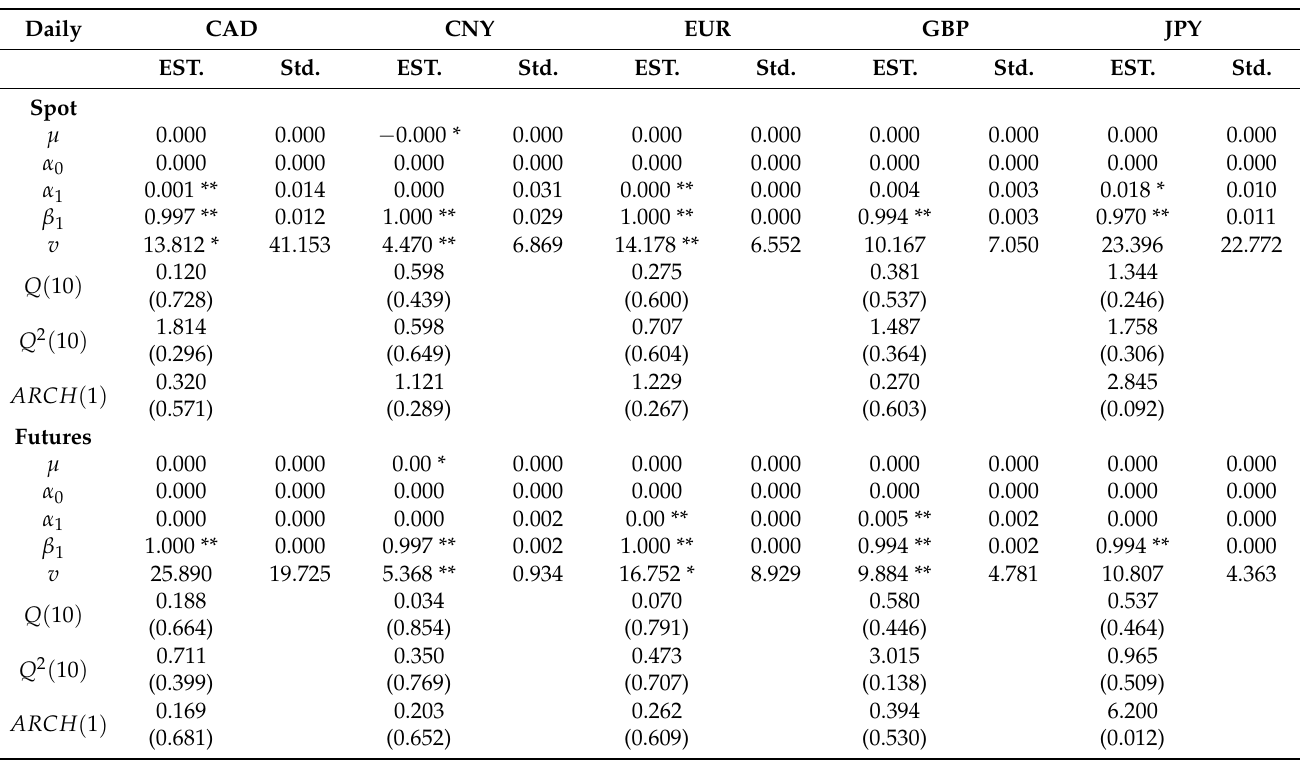
Table 6. Results from the GARCH(1,1) model estimation for one-day spot and future